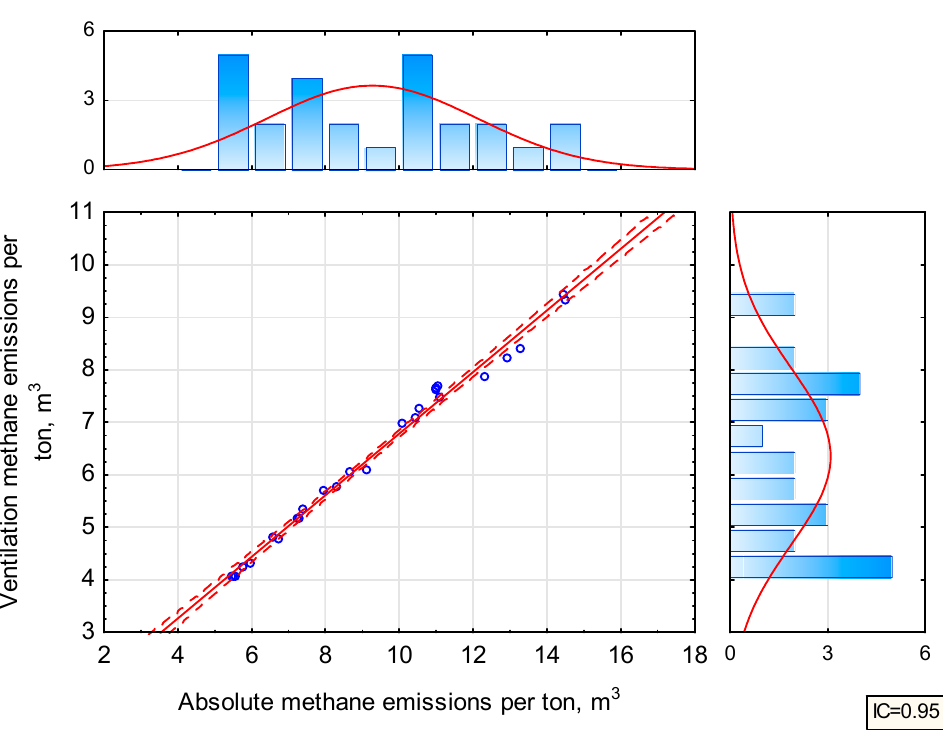
Figure 8. Relationship between absolute methane emissions and ventilation methane emissions per one ton in hard coal mines in Poland.